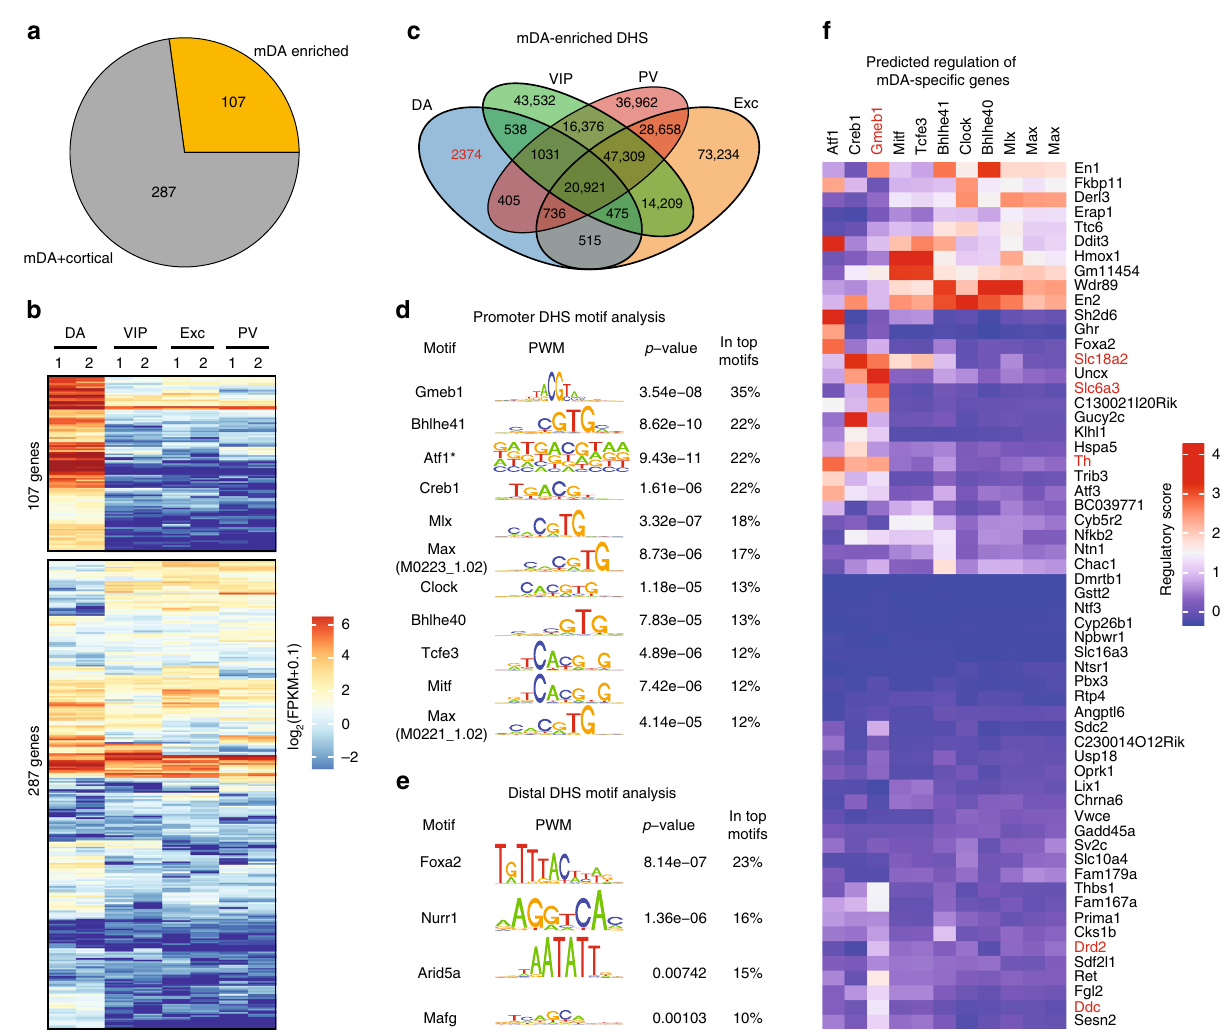
Fig. 2 Transcriptome and DHS analysis reveals putative mDA transcriptional regulators. a Pie chart showing the number of genes signi fi cantly enriched in HA + mDA neurons compared with VIP, Exc, and PV cortical neuron-expressed genes (FC > 4 and q -value < 0.001, FPKM> 1). b Heatmap showing the 394 genes, respectively, expressed in the HA + mDA neurons, as well as VIP, Exc, and PV cortical neurons. The 107 genes signi fi cantly enriched in mDA neurons (top) are termed “ mDA-enriched ” genes. c Venn diagram showing the overlap between the 28,084 mDA neuron DHS sites ( q -value < 0.05) with the ATAC-Seq accessible chromatin regions ( q -value < 0.05) in VIP, Exc and PV cortical neurons. The 2374 DHS sites present only in mDA neurons were termed “ mDA-enriched DHS ” . d List of the motifs identi fi ed at the promoter DHS of mDA-enriched genes ( q -value < 1e − 4). Each base-pair of the motif is proportional to its information content pro fi le 49 . The Atf1 motifs with a * to indicate the low information content along all the positions, thus its motif was instead represented by the relative base frequency. The identi fi er under the Max motif indicate the motif PWM ID in the CIS-BP database 50 . e List of motifs identi fi ed at mDA-enriched distal DHSs of mDA-enriched genes ( q -value < 0.01). Each base-pair of the motif is proportional to its information content pro fi le 49 . f Heatmap showing the predicted TF regulatory score (TFRS) associating each TF to the mDA-enriched genes with a promoter